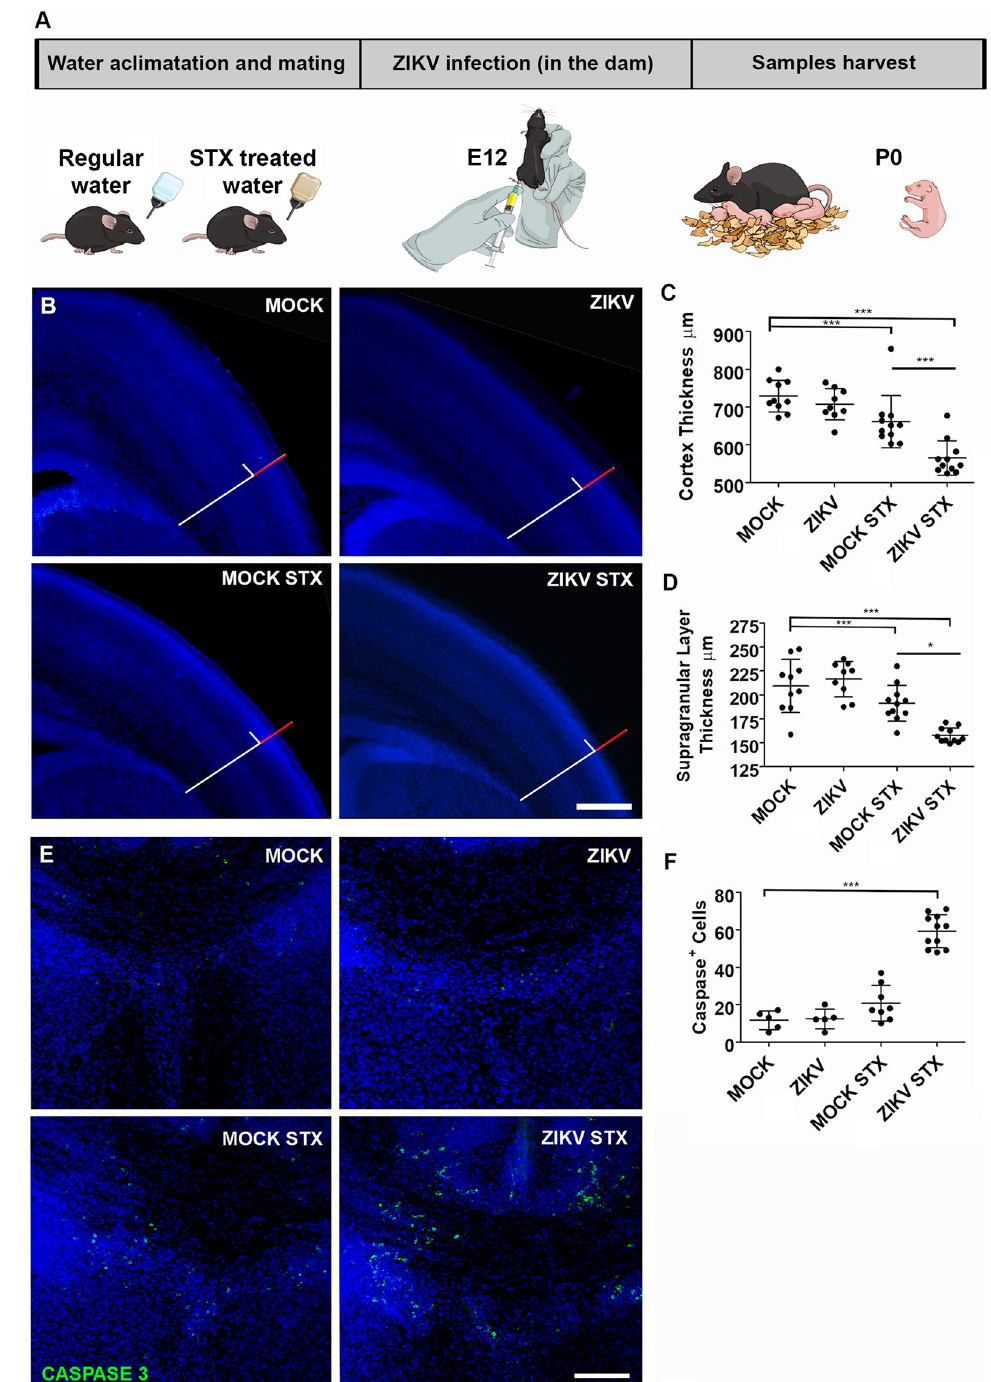
Fig 3. Mice offspring chronically exposed to STX during pregnancy presents congenital zika syndrome exacerbation. C57BL/6J pregnant mice continuously exposed to STX were infected with 10 6 PFU of ZIKV intraperitoneally at E12. (A) Illustration showing the experimental timeline. (B) Representative images were taken from the same correspondent cortical areas, in coronal sections at the level of anterior commissure crossing. Nuclei were stained by DAPI. A reference line was traced radially in the Mock tissue, starting at the pallium-subpallium border from the pia-mater until the proliferative zone. Cortical erosion (red part of the line) was illustrated in the images based on the ZIKV STX image. Cortex (C) and proliferative supragranular cortical layers (D) thickness was measured among groups (mean ± SEM). (E) Representative coronal sections of the cortical midline where nuclei were stained by DAPI in blue and apoptotic cleaved- caspase 3 positive cells were stained in green. Scale bar means 400 μ m (B) or 100 μ m (E). (F) Quantification of caspase- positive cells per area (mm 2 ) (mean ± SEM). ANOVA, ��� p < 0.001, �� p < 0.01 and � p < 0.05.